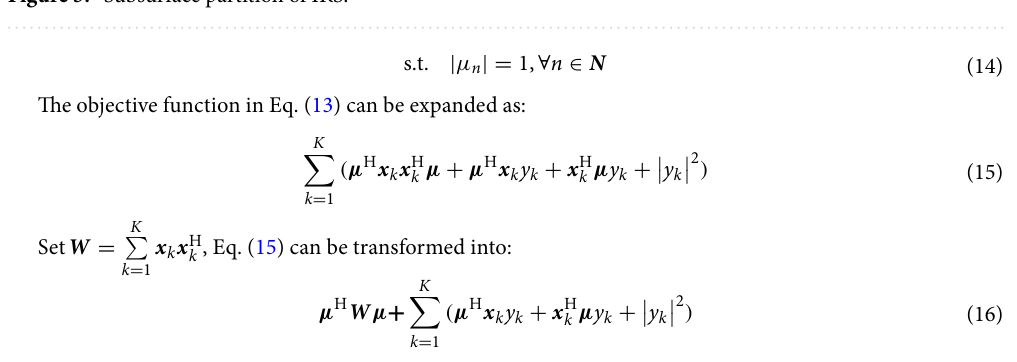
Figure 3. Subsurface partition of